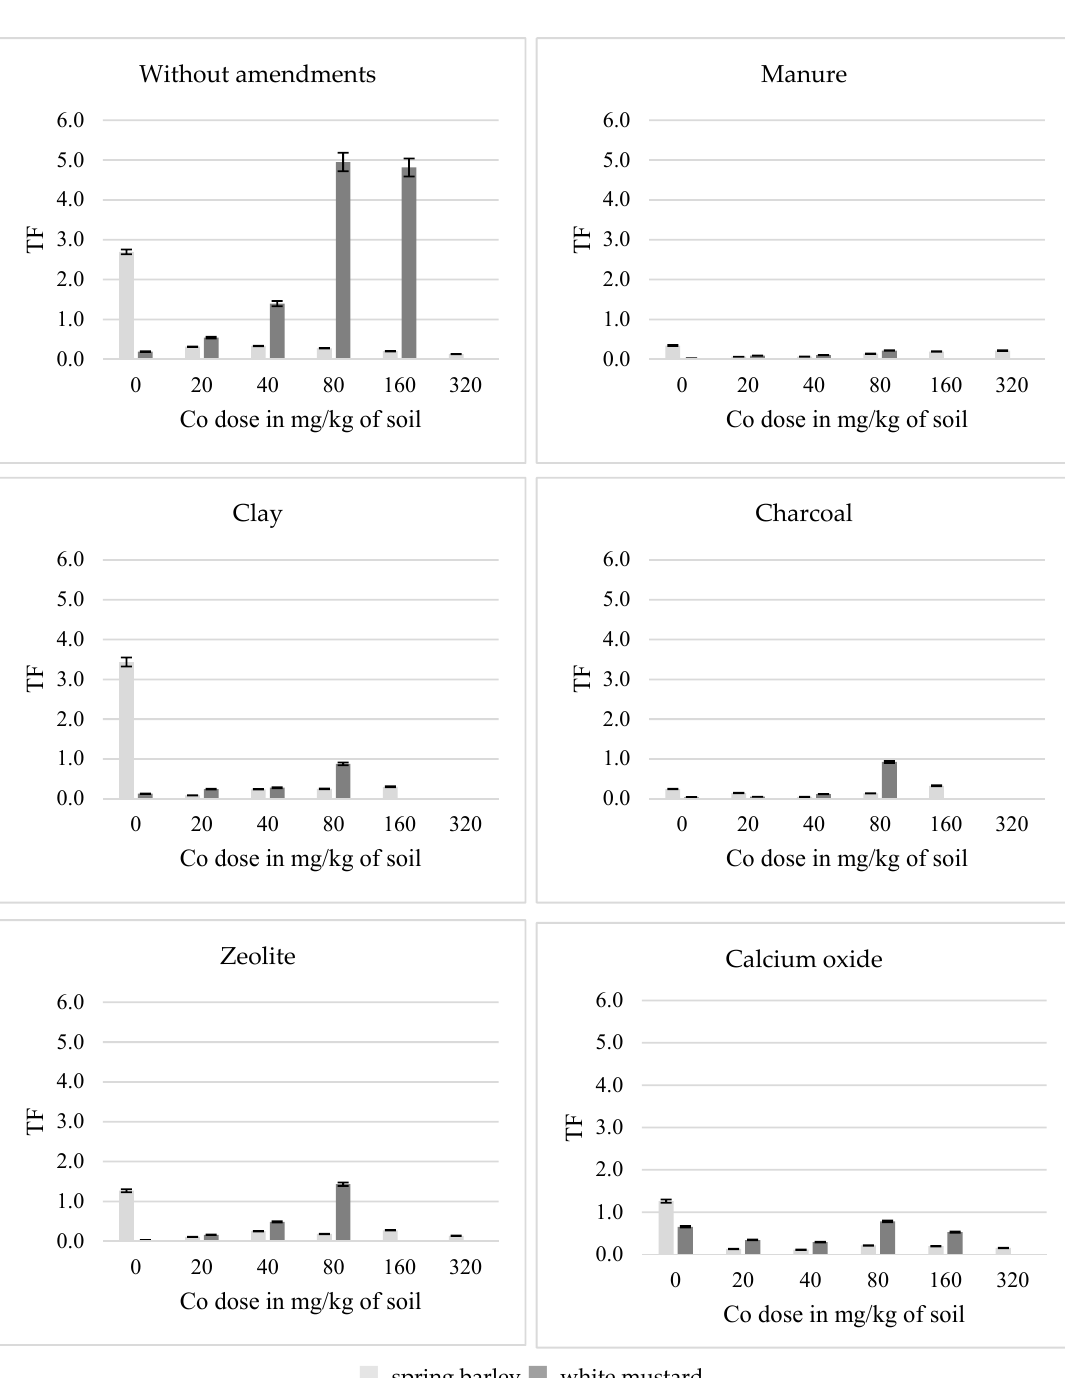
Figure 4. Translocation factor (TF) of cobalt in spring barley and white mustard.